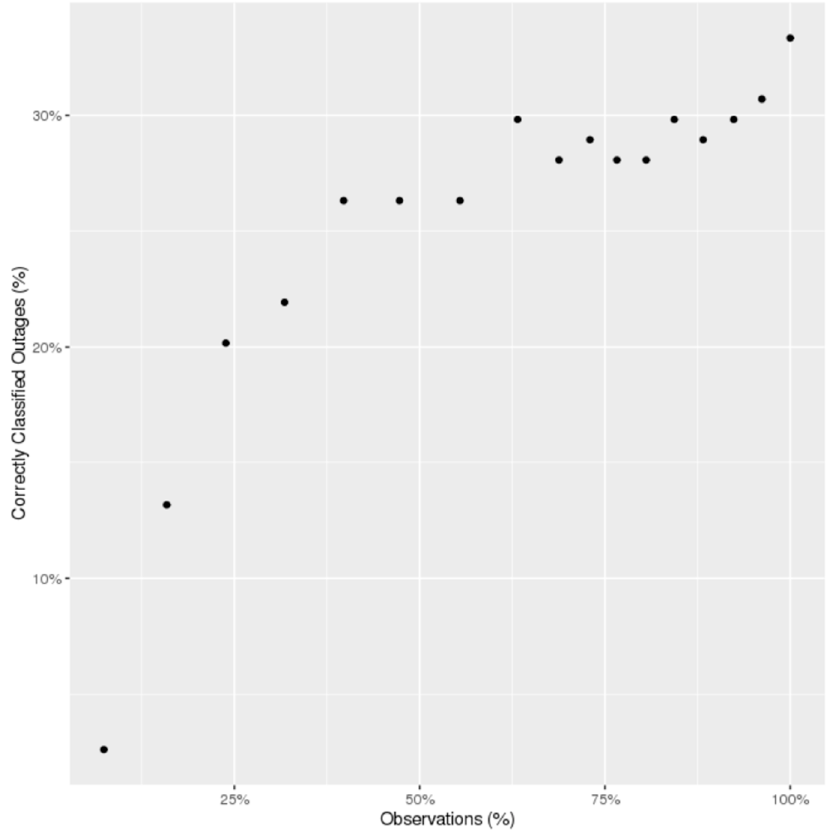
Figure 4. Model sensitivity to increased number of observations from all sites. The percentage of correctly classified individual outages as a function of the number of observations used for classification, starting with observations at the peak of monsoon season.